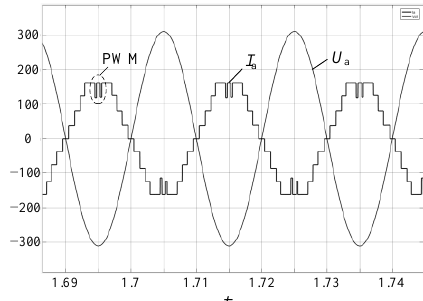
Fig. 17. Diagrams of the input current and voltage of phase A. 24-pulse converter is operating in the inverter